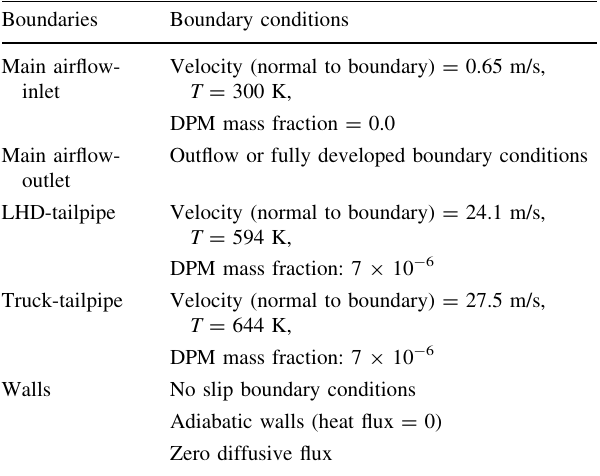
Table 1 Boundary conditions used for DPM simulation Boundaries Boundary